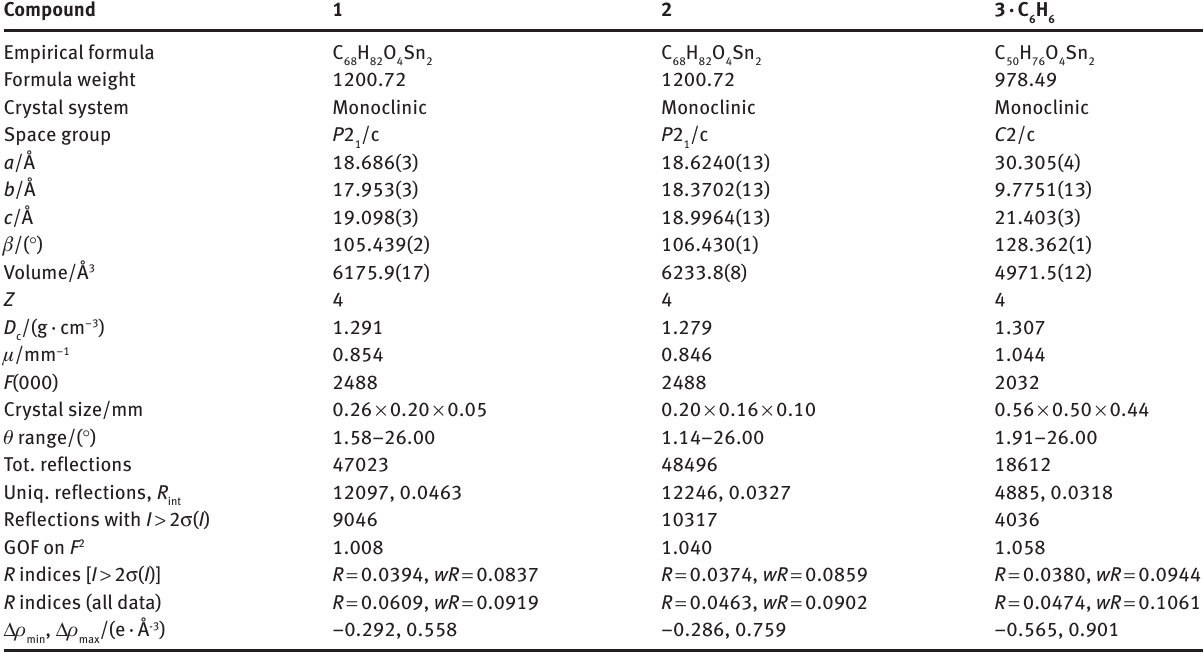
Table 2: Crystallographic and refinement data of 1–3